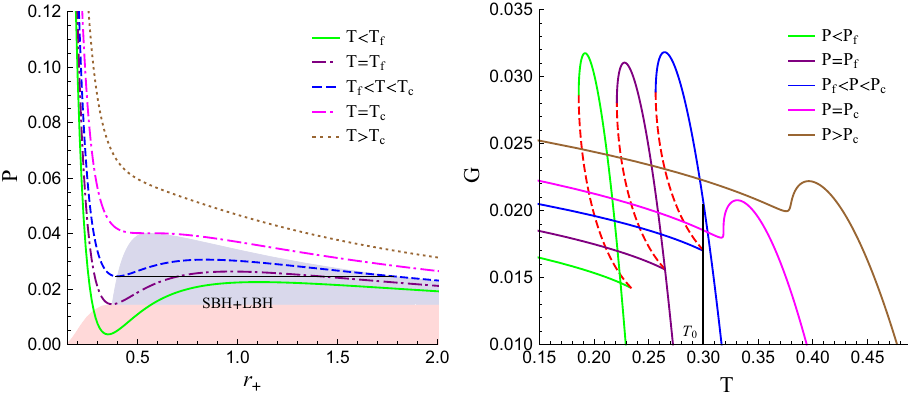
Fig. 4 P − r + and G – T diagrams for different regions of temperature and pressure. In P − r + diagram, the horizontal black line indicates a zeroth order SBH–LBH phase transition. Besides, the shaded area indicates SBH+LBH coexistence region. In the right panel, the solid lines correspond to C P > 0 whereas the dashed red lines are related to